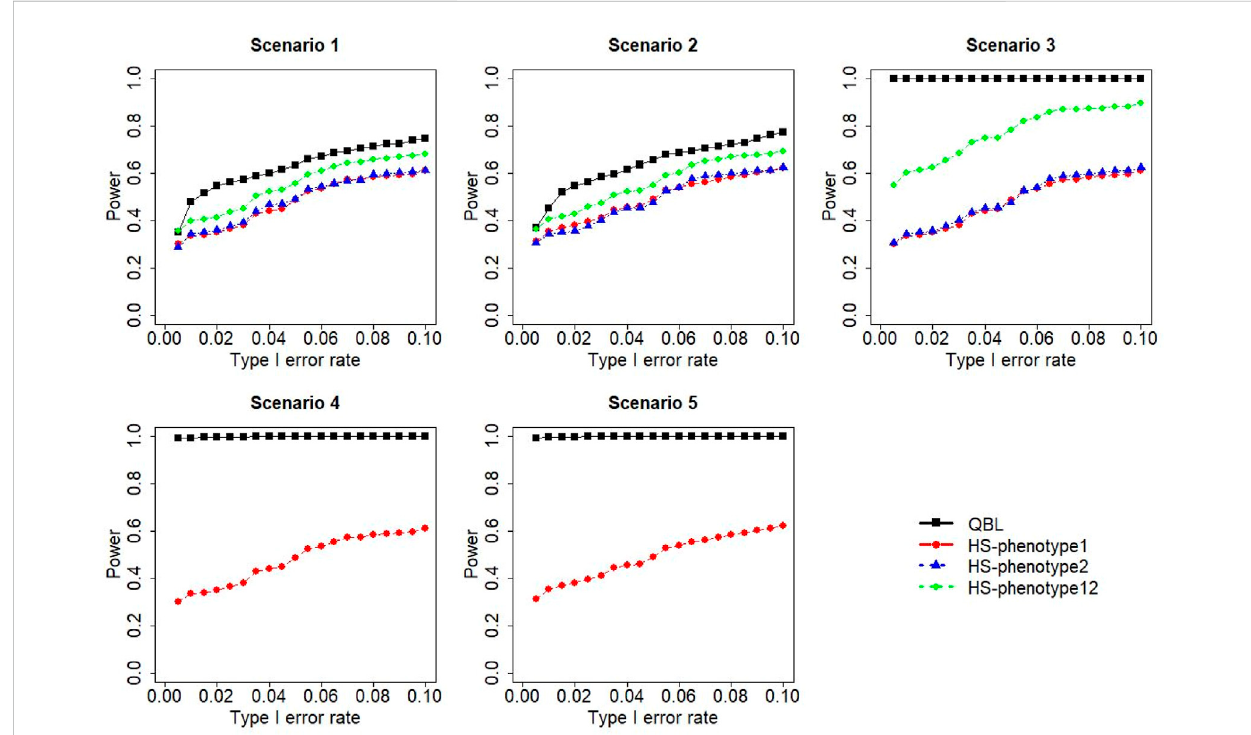
FIGURE 3 Simulation results under sample size 500, setting 1 (six haplotypes), and ρ = 0.9. Scenarios are shown in Table 1. HS, Haplo.score; phenotype12, phenotype 1 or